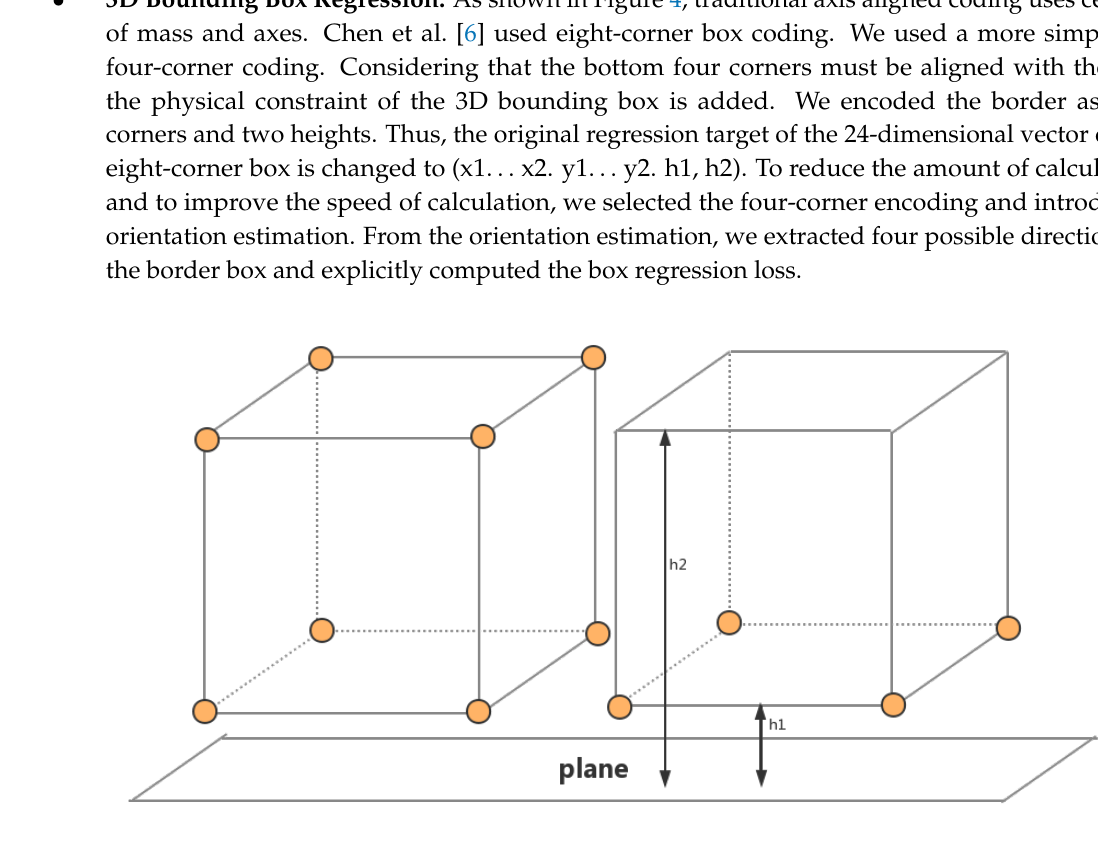
Figure 4. Modified Resnet-50 feature